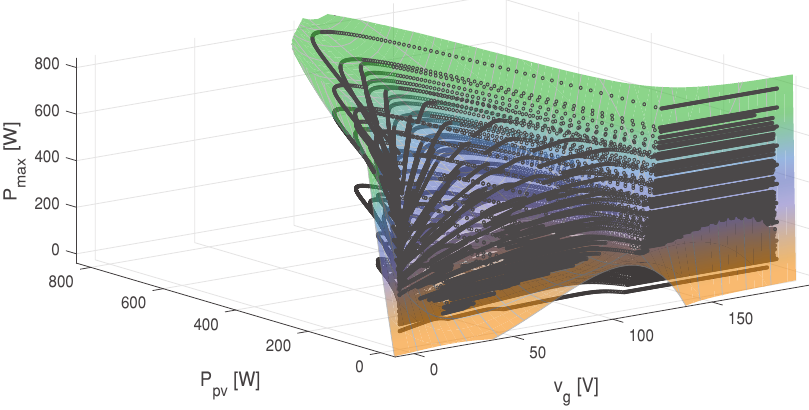
Figure 2. Plotting of the MPP surface in terms of P pv and v g